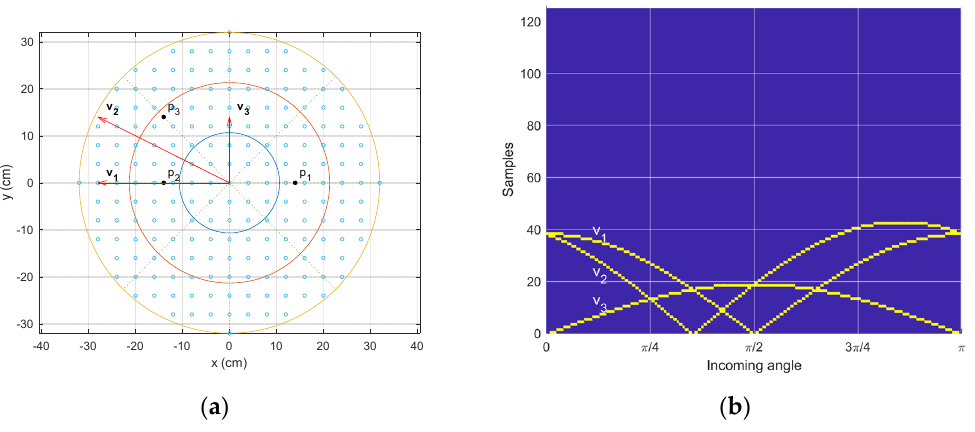
Figure 5. Receiver configuration and time delay distribution. ( a ) Receiver grid—black circles ( p ) indicate one example receiver location, and red arrows ( v 1 , p 2 , p 3 between the receivers in the given configuration. ( b ) Time delay distribution for the given incoming angles. The yellow points provide the actual time delay (samples) created by the corresponding vectors ( v 1 , v 2 , v 3 )